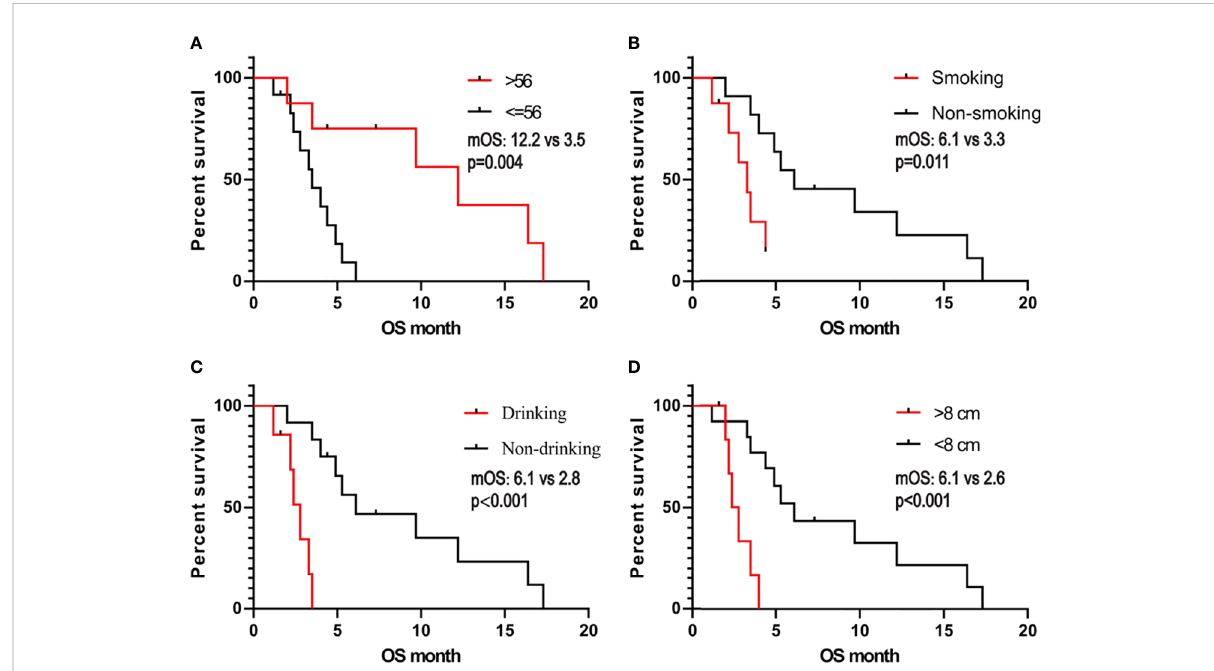
FIGURE 4 Kaplan- Meier estimates of overall survival in SHC comparing patients with (A) age, (B) smoking, (C) alcohol consumption, and (D) tumor